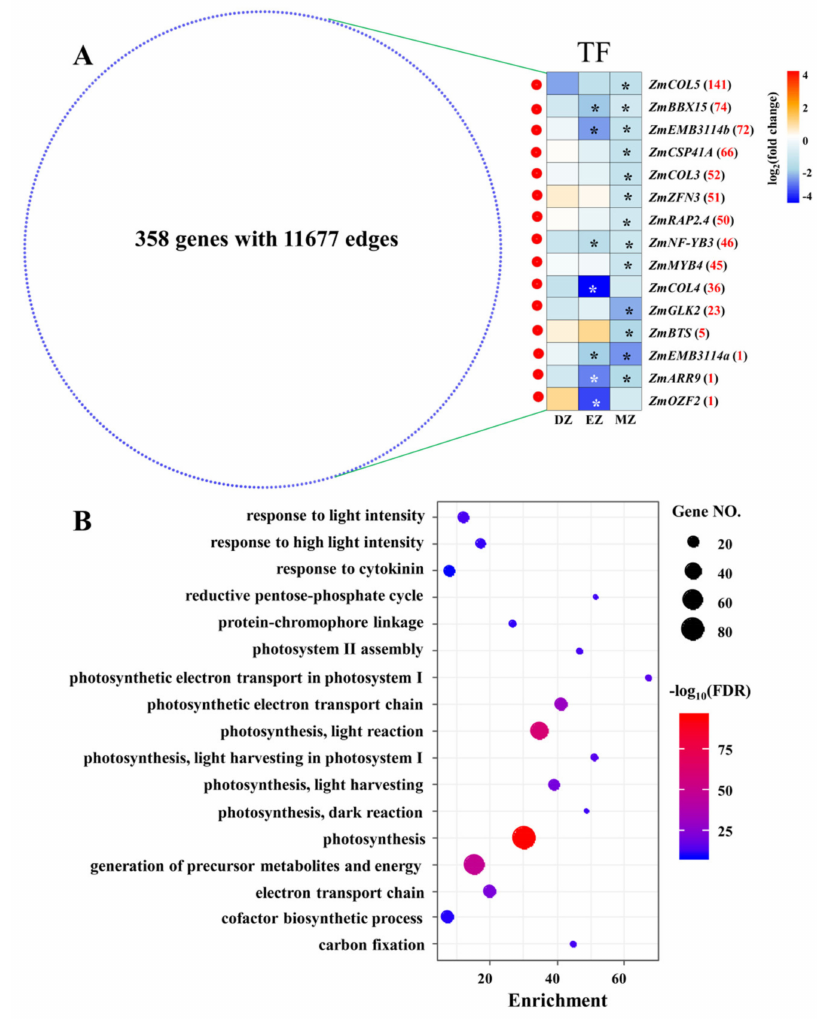
Figure 6. Network derived from CM blue with weighted value above 0.5 ( A ). The red and blue nodes represent transcription factors (TF) and other genes, respectively. The expression profiles of TF in the three comparisons are shown as a heatmap. The stars in the heatmap indicate the significance of genes under a certain comparison (FDR ≤ 0.05). The red numbers behind the gene name represent the number of coexpressed genes for each TF. COL, CONSTANS-LIKE; BBX15,